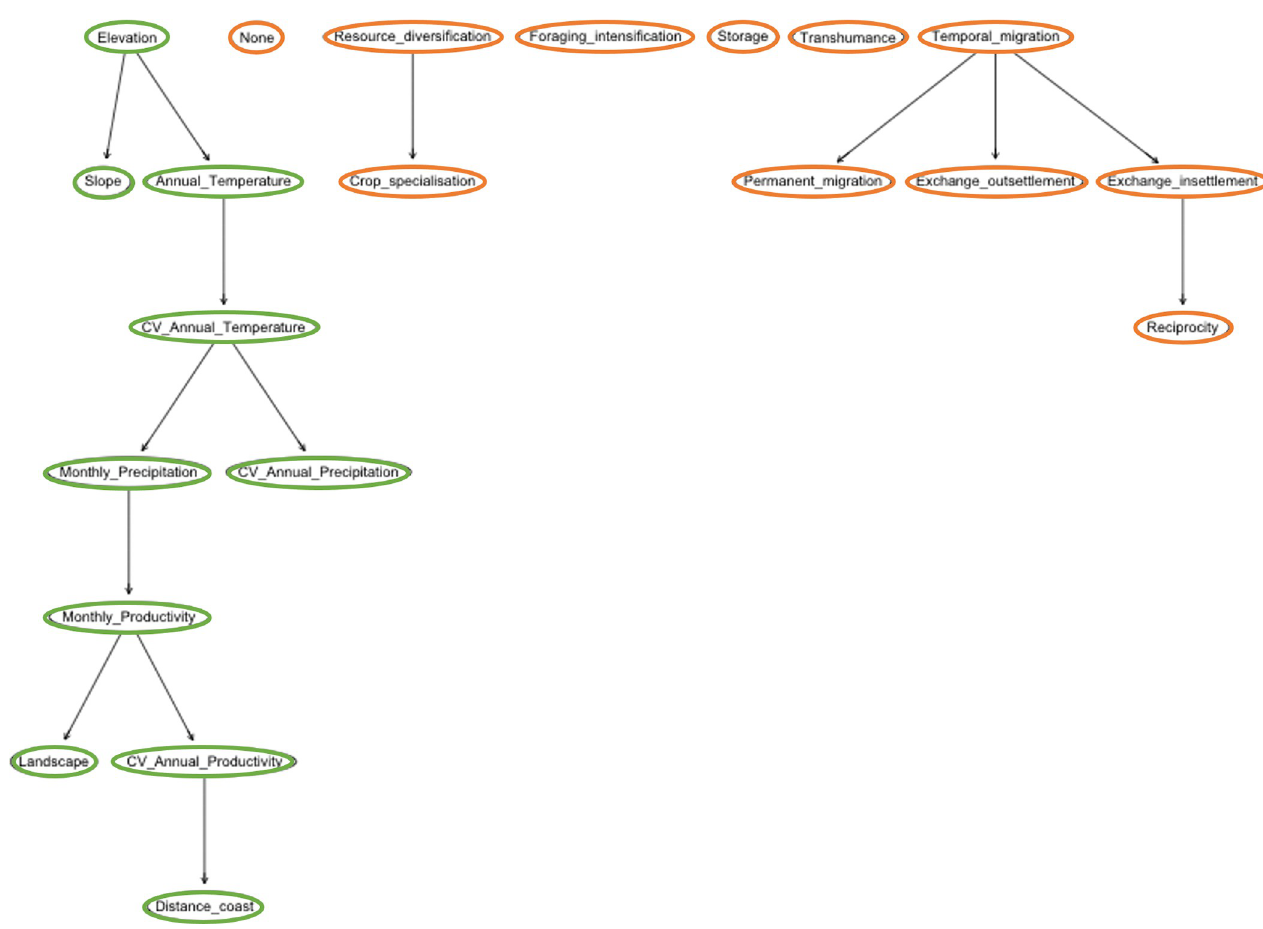
Fig 8. Model B representing the relationship between the environment and social decisions. This model structure is the one with the highest accuracy for this scenario and allows us to observe how strategies that imply movement (e.g., migration, exchange, etc.) are closely related.